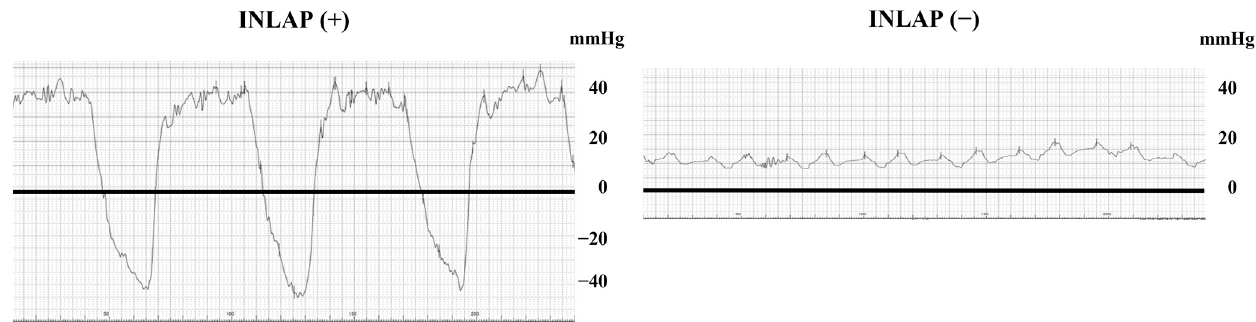
Figure 1. Representative LAP curve during inspiration with and without INLAP. The bold line indicates a level of 0 mmHg. The left panel shows a representative case with INLAP. LAP shows a significant respiratory change from − 30 to 40 mmHg. Abbreviations: INLAP, inspiration-induced negative left atrial pressure; LAP, left atrial pressure.